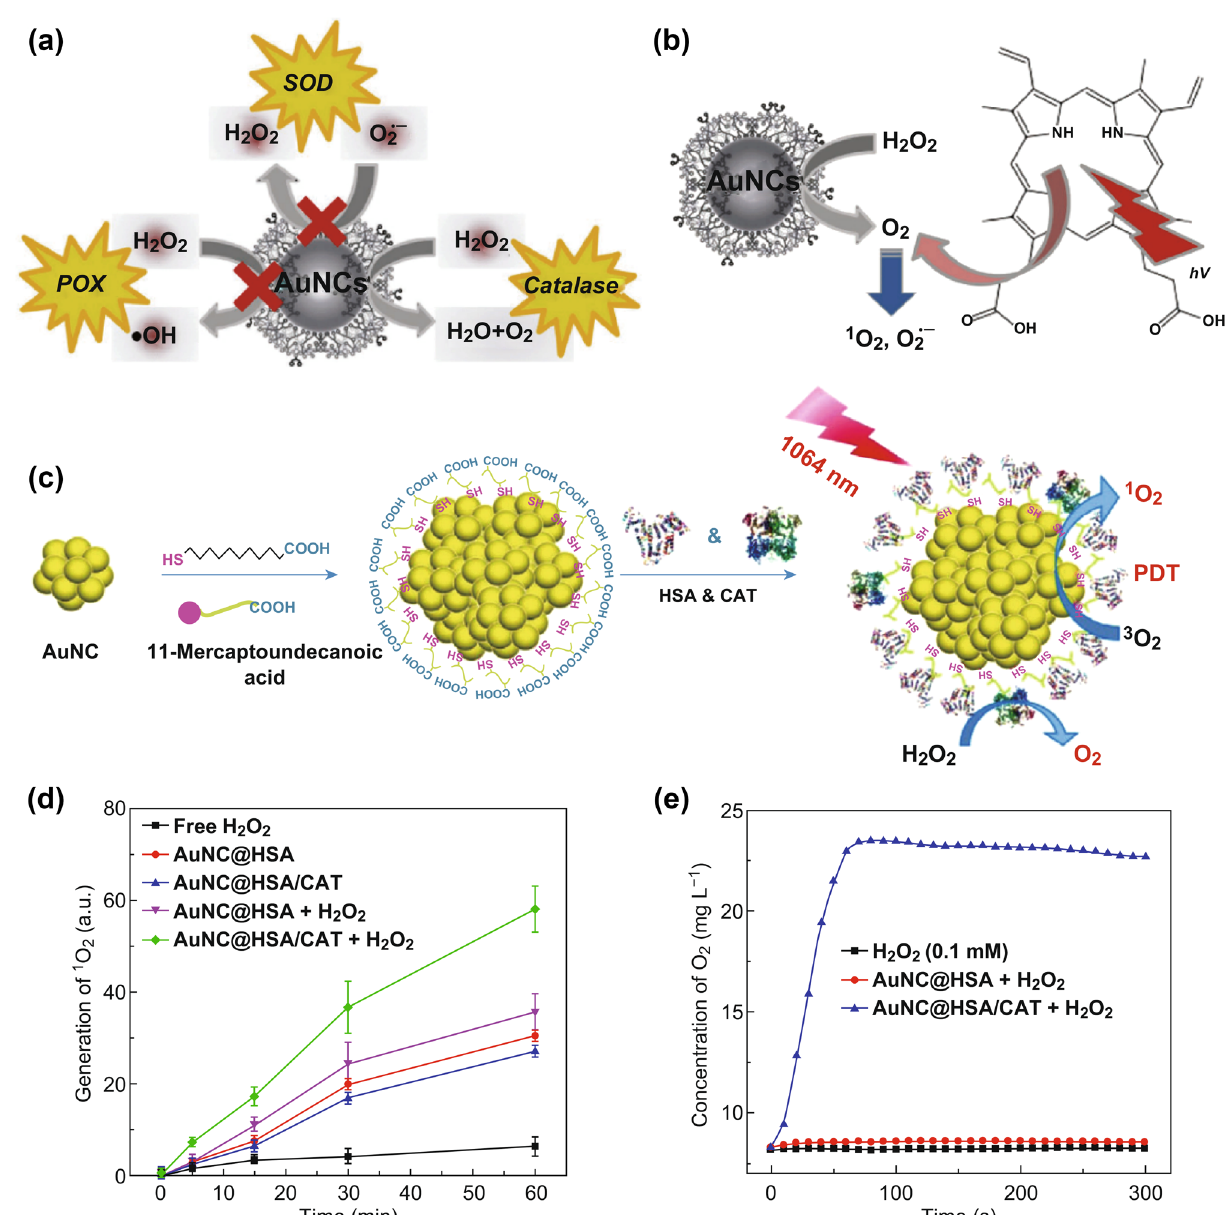
Fig. 4 a Schematic diagram of enzyme-like activity of AuNCs. b Through the catalase activity of AuNCs-NH 2 , a simple strategy of combin- ing traditional PDT with self-supplying O 2 leads to increase in 1 O 2 and O 2•− generation. Adapted with permission from Ref. [32]. Copyright 2017 Wiley–VCH. c Schematic illustration of the synthesis of AuNC@HSA/CAT nanoparticles. d 1 O 2 generation for AuNC@HSA or AuNC@ HSA/CAT with or without addition of H 2 O 2 . e O 2 generation in H 2 O 2 solutions (100 μM) incubated with AuNC@HSA or AuNC@HSA/CAT. Adapted with permission from Ref. [33]. Copyright 2017